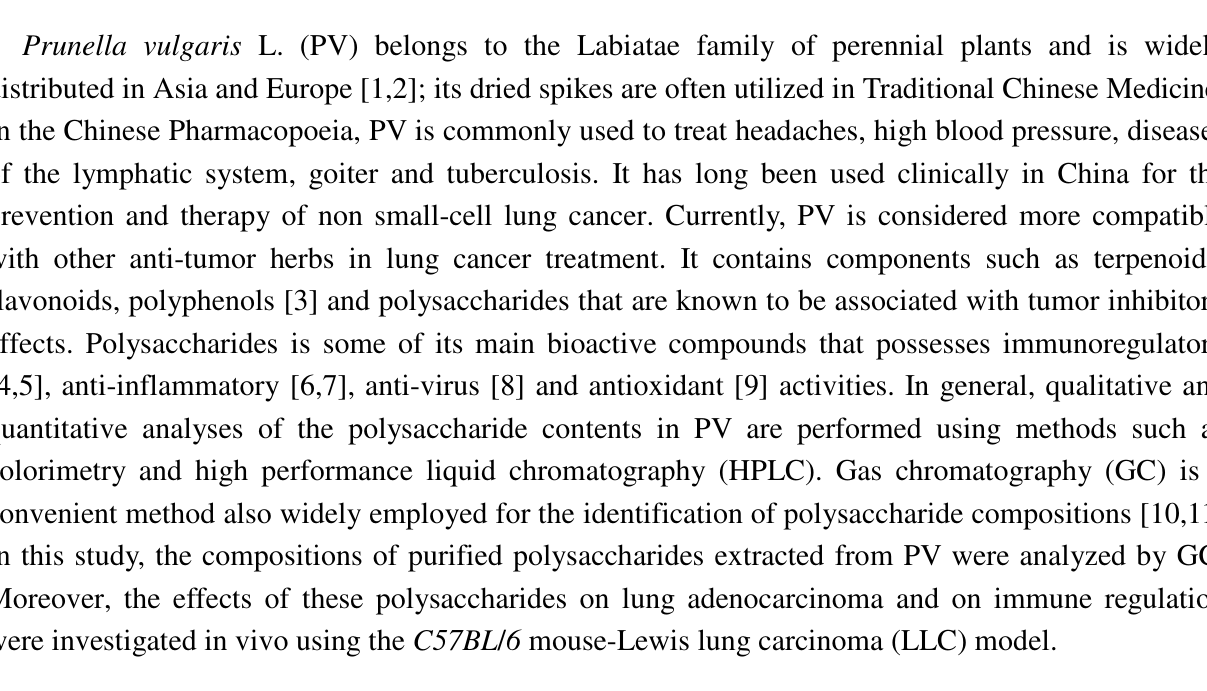
Figure 1. The UV absorbance spectra of polysaccharide before and after deproteinization.